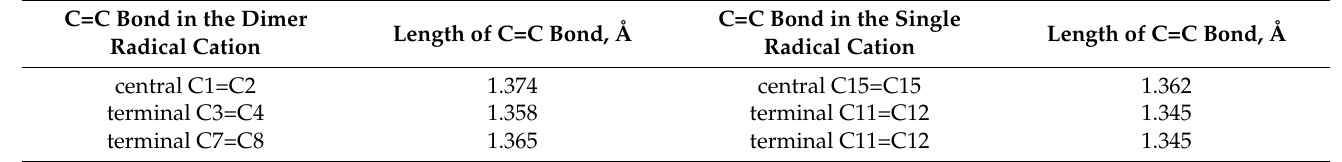
Anionic layers are formed by isolated anions [ReO 4 ] − . Each Re atom has a tetrahedral environment and is bonded to four oxygen atoms (Figure 6b). Between the BDH-TTP molecules and [ReO 4 ] − tetrahedra there are short C...O and S...O contacts as well as intermolecular C-H . . . O contacts (see Table 4). The Re-O bond lengths in the tetrahedra are within the interval 1.700–1.786 Å range, Table S2, Supplementary